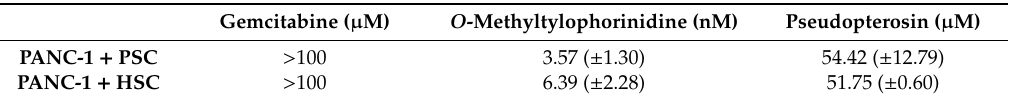
Table 3. IC 50 values of cell death induced by O -methyltylophorinidine, pseudopterosin A-D, and gemcitabine treatment of 3D co-culture spheroids composed of the PDAC cell line Panc-1 and the stellate cells PCS or HCS, respectively *.